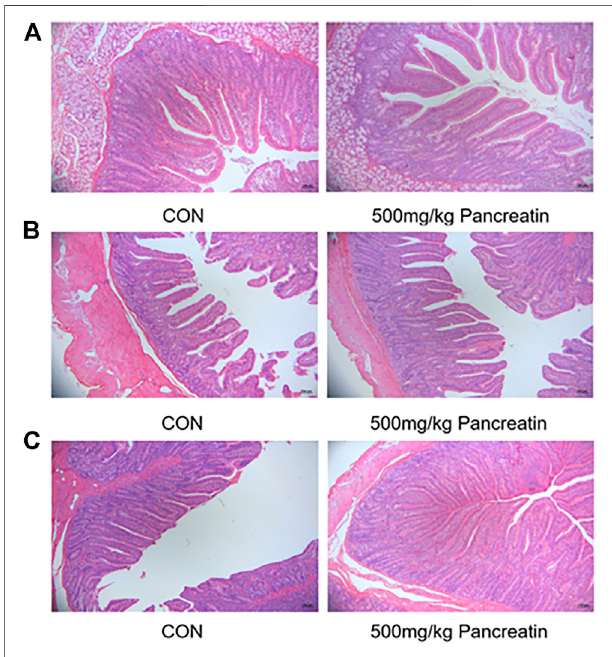
FIGURE 2 | Morphology of duodenum (A) , jejunum (B) , and ileum (C) of piglets fed with control and 500 mg/kg